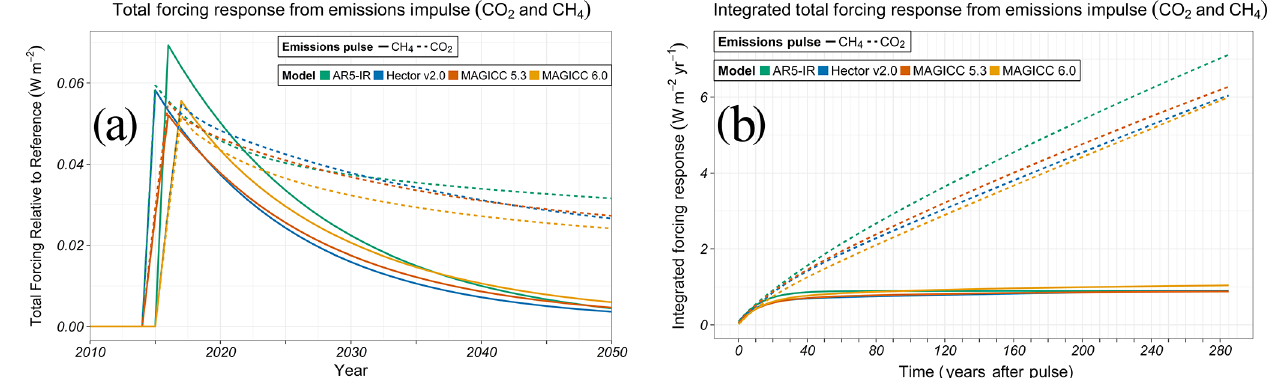
Figure 2. Total forcing response from CO 2 (dashed) and CH 4 (solid) emissions perturbations in SCMs (MAGICC 6.0 – yellow, MAG- ICC 5.3 BC–OC – red, Hector v2.0 – blue, AR5-IR – green). FAIR does not report forcing. We report the total forcing response, which has slight differences from the gas-only forcing response. The perturbations are conducted in 2015 against the background of the Representative Concentration Pathway (RCP) 4.5 scenario (see Methods). The time-integrated response, analogous to the absolute global warming potential, is reported as 0–285 years after the perturbation (Sect. S8).